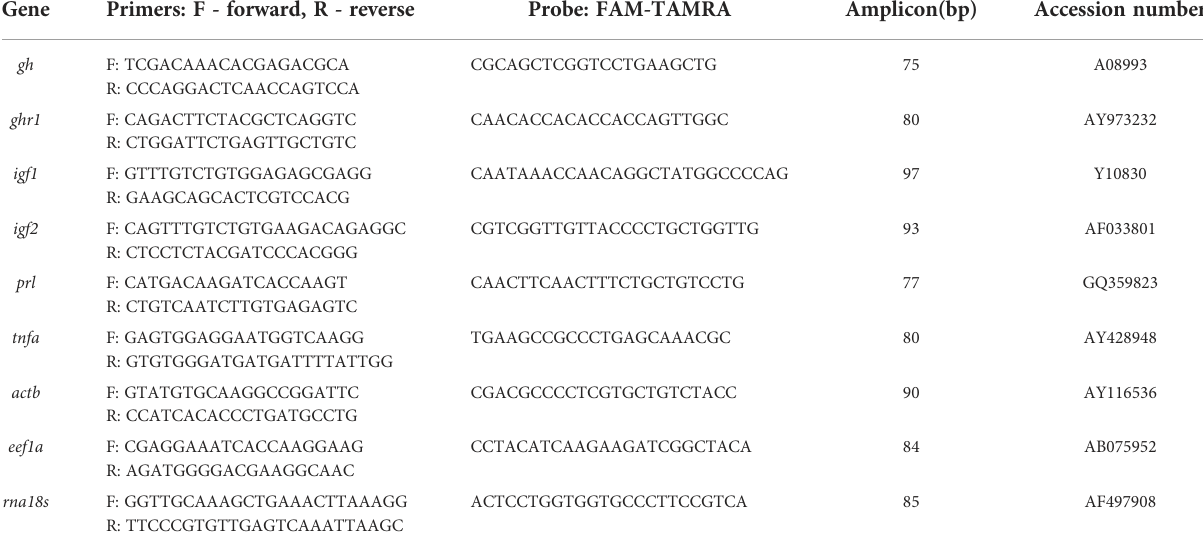
TABLE 1 Quantitative real-time PCR assays used in this study.